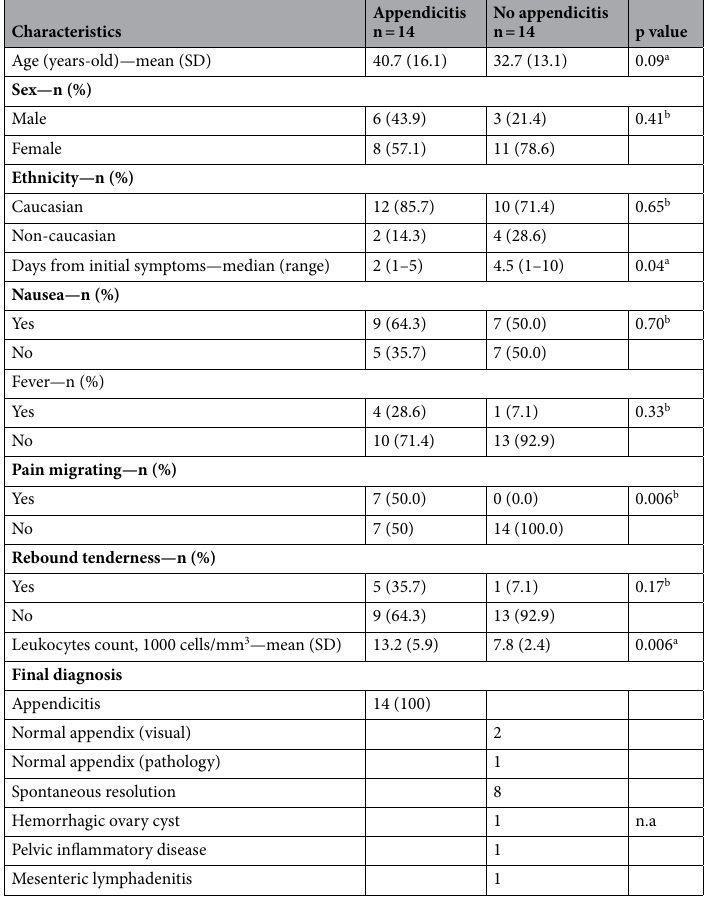
Table 1. Characteristics of the studied population. n.a. not applicable. a Mann–Whitney. b Fisher Exact